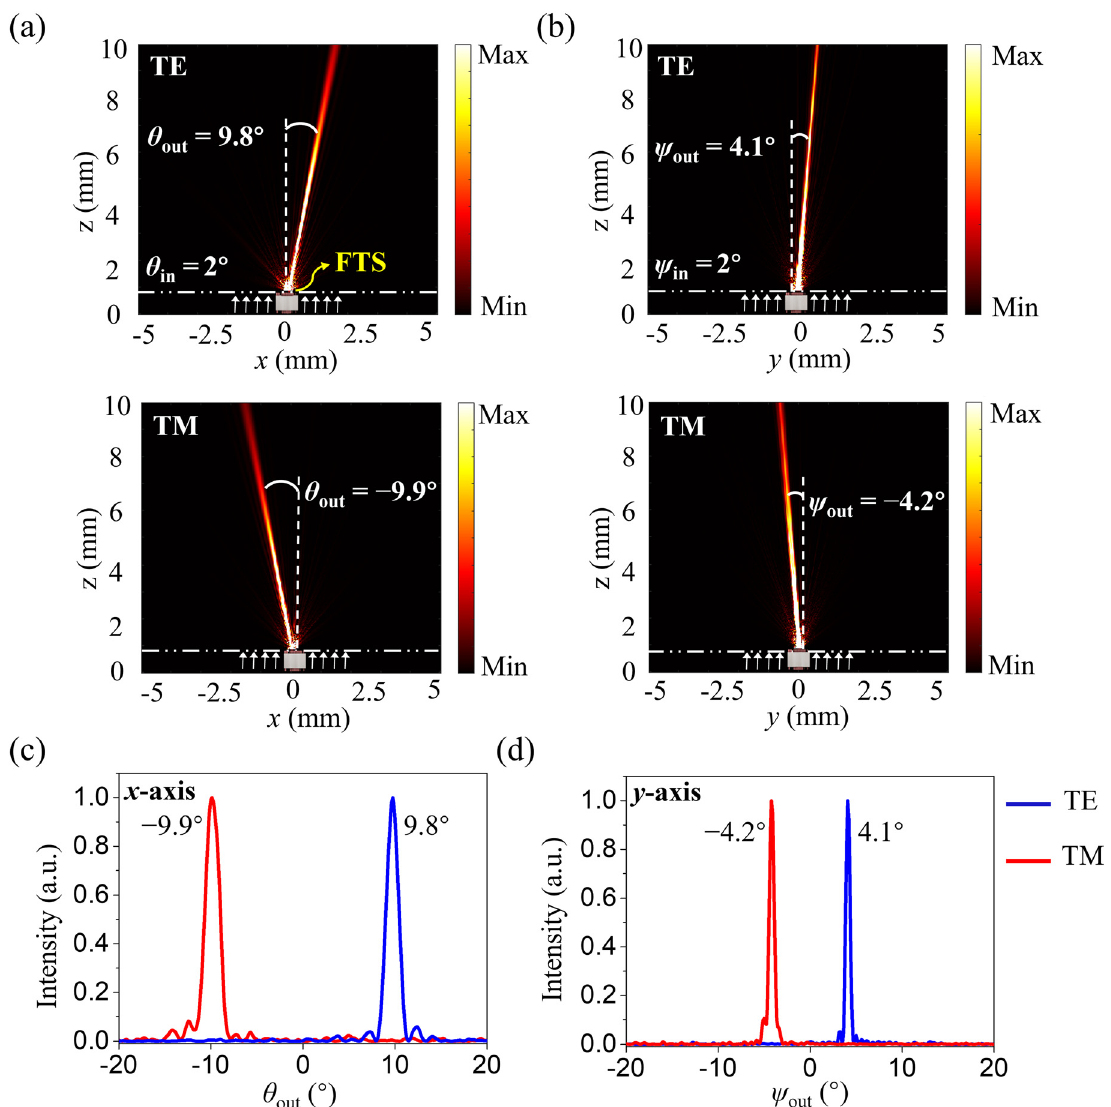
Figure 3: Simulation results for the developed FTS at a wavelength of 1550 nm: E- fi eld distributions with θ in = + 2 ° and ψ in = + 2 ° in the (a) xz - planeand(b) yz -planeforTEandTMpolarizations,respectively.Thewhitearrowsindicatethepropagationdirectionoftheincidentbeam.Far- fi eld intensity distributions of the de fl ected beam along (c) x -axis and (d) y